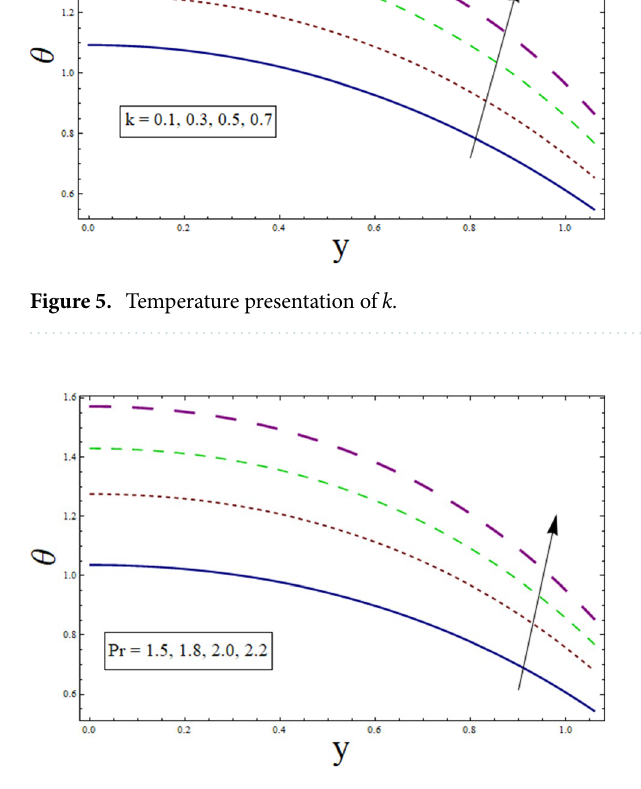
Figure 6. Temperature presentation of Pr .